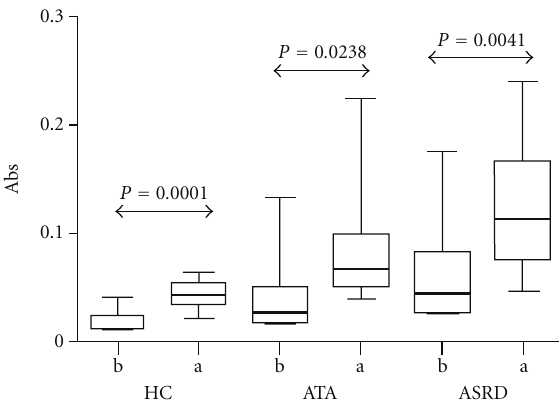
Figure 2: Determination of galectin-10 by ELISA at baseline in nasal lavage fluid of aspirin sensitive respiratory disease patients (ASRD), aspirin-tolerant asthmatics (ATA) and healthy controls (HC).